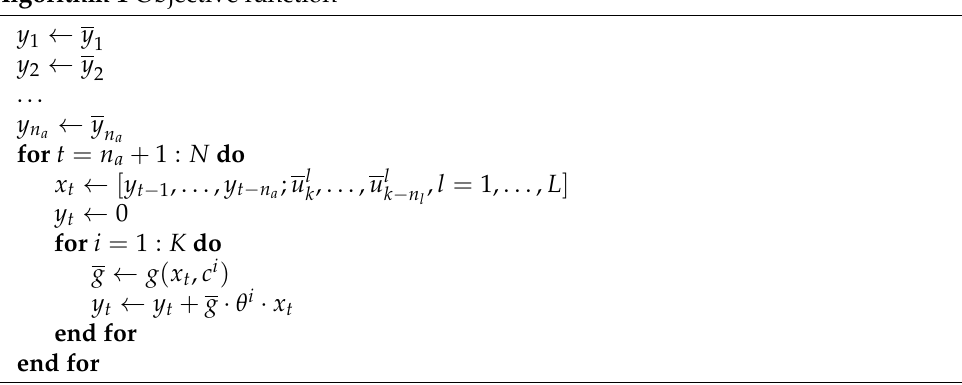
Algorithm 1 Objective